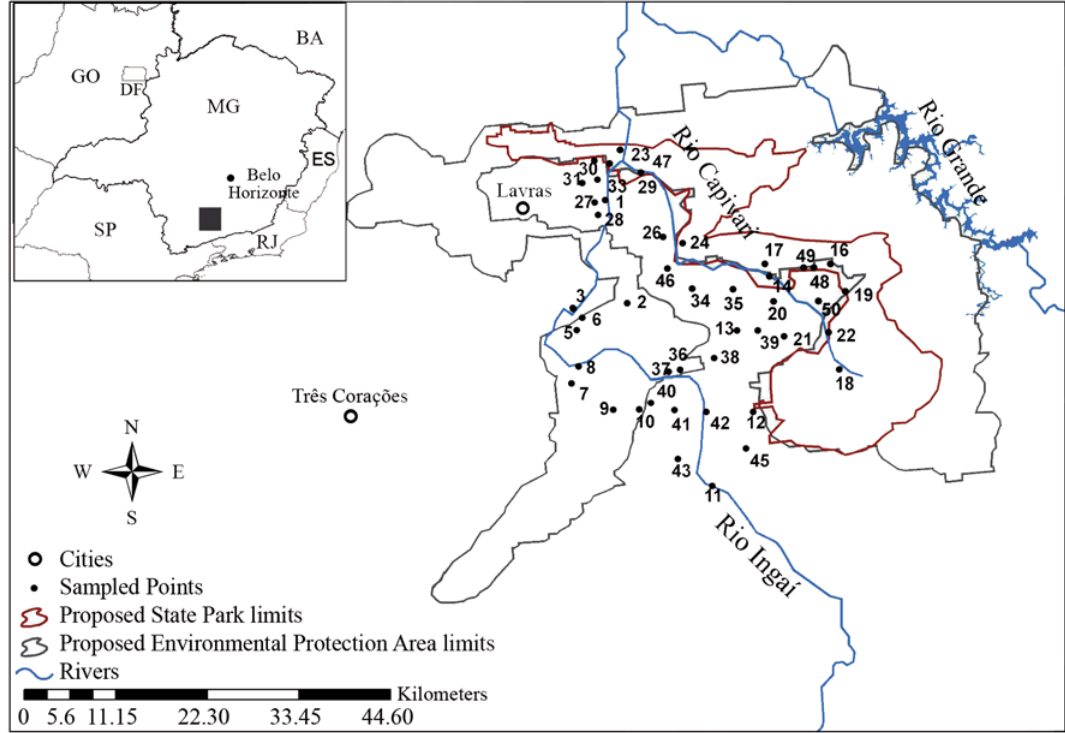
Fig. 1. Map indicating sampling points and proposed boundaries for a State Park and an Environmental Protection Area (EPA) based on Zambaldi et al . (in